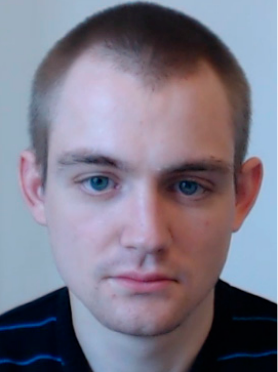
Figure 1. Example of the person perception task.